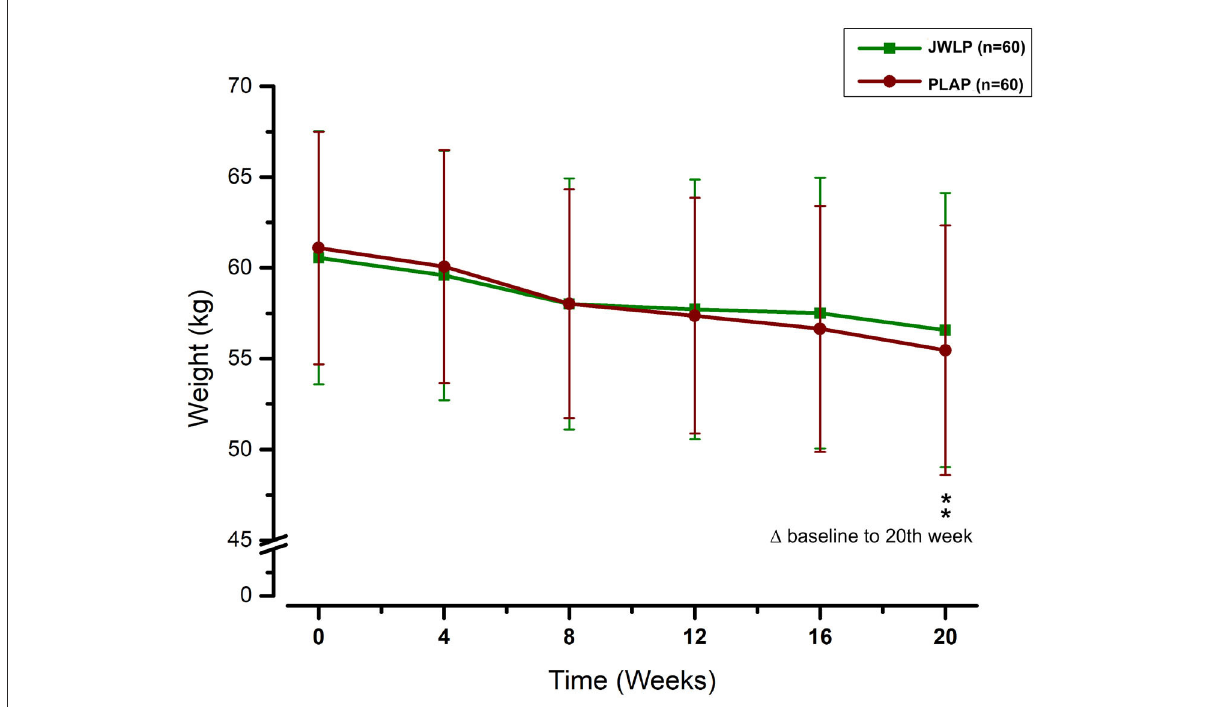
FIGURE6 The development of the weight over the 20 week trial period. ** p <